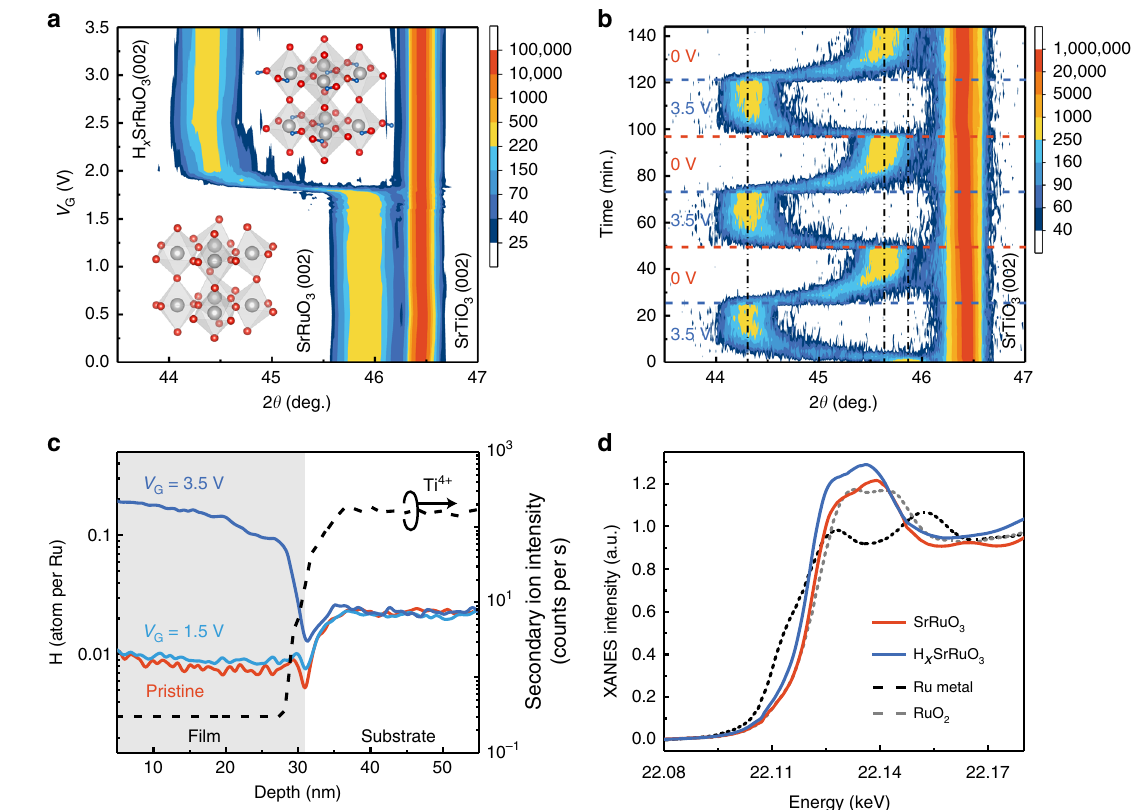
Fig. 1 Electrically controlled proton evolution in SrRuO 3 fi lms. a In-situ XRD θ -2 θ scans around the SrRuO 3 (002) peak as a function of V G . The new phase is denoted as H x SrRuO 3 . The insets show calculated crystal structures of SrRuO 3 and HSrRuO 3 , respectively, where the blue balls represent hydrogen atoms. b In-situ XRD θ -2 θ scans around the SrRuO 3 (002) peak as V G cycled between 3.5 V and 0 V, indicating the reversibility of the structural phase transformation. The black dotted lines indicate the peak positions, and the blue and red dash lines denote the change of V G . c Hydrogen distribution pro fi les within both pristine SrRuO 3 fi lm (red solid line) and gated (with V G = 3.5 V and 1.5 V) SrRuO 3 fi lms, as measured by ex-situ SIMS. The Ti 4 + signature was used as a marker to de fi ne the interface between fi lm and substrate. d In-situ XANES spectra at Ru K-edge for pristine SrRuO 3 (orange solid line) and protonated H x SrRuO 3 (blue solid line) at V G = 3.5 V. The XANES spectra at Ru K-edge for Ru metal (black dash line) and RuO 2 (gray dash line) are shown as